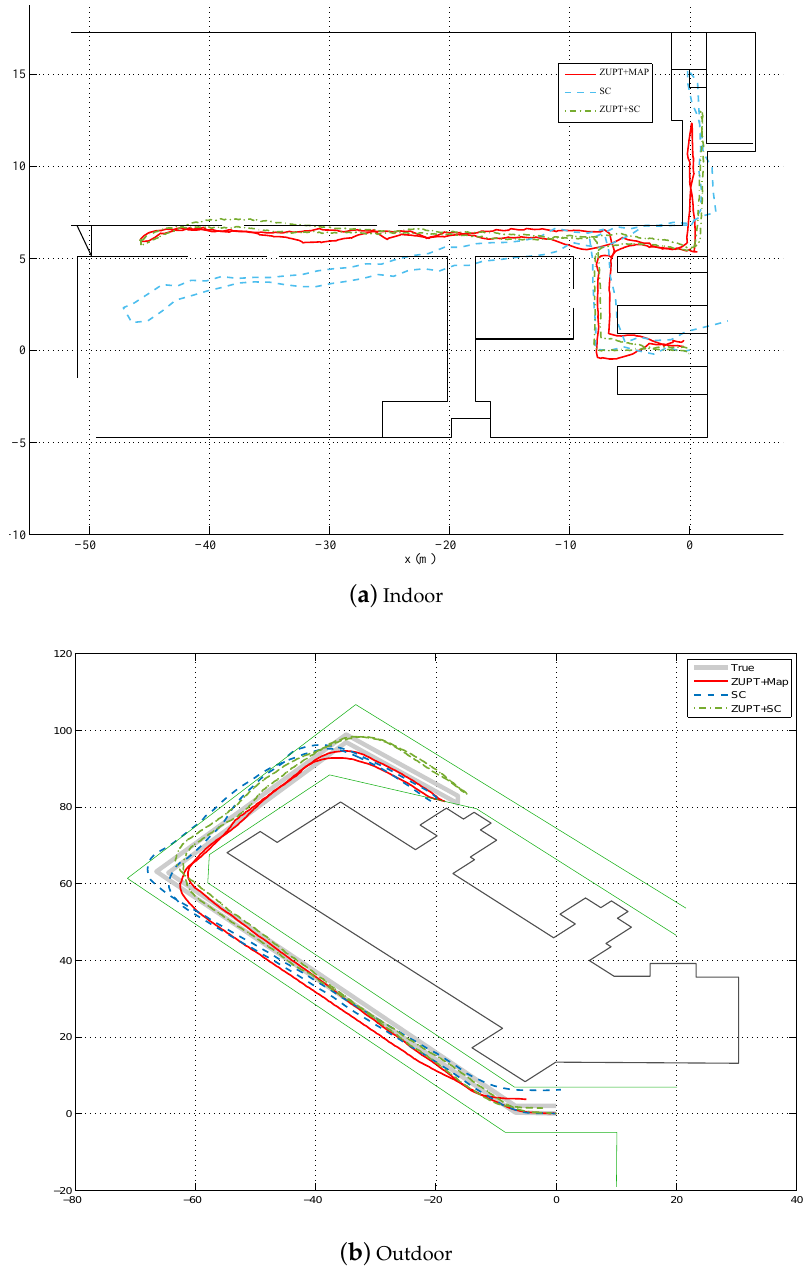
Figure 8. Comparative results with our previous methods presented in [10] and [12]. ( a ) Indoor scenario; and ( b ) Outdoor scenario. For both figures, “ZUPT+SC” is for fusion of ZUPT and step counter presented in [10], “SC” is for the step counter method presented in [12], and “ZUPT+Map” is for fusion of ZUPT and map proposed in this